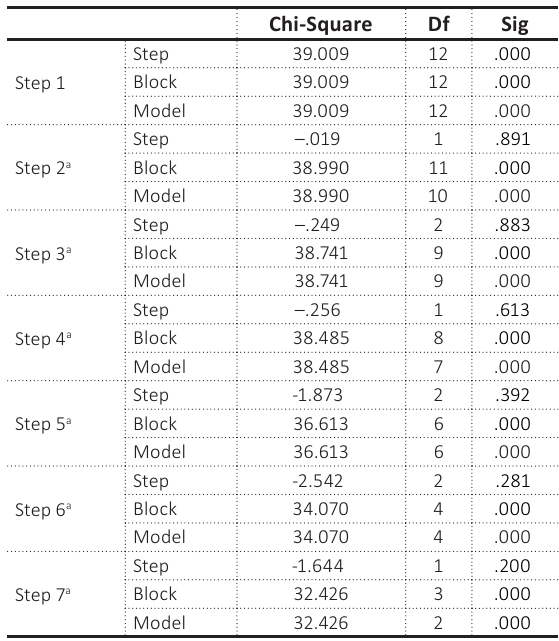
Table 7. Omnibus test of model coefficients